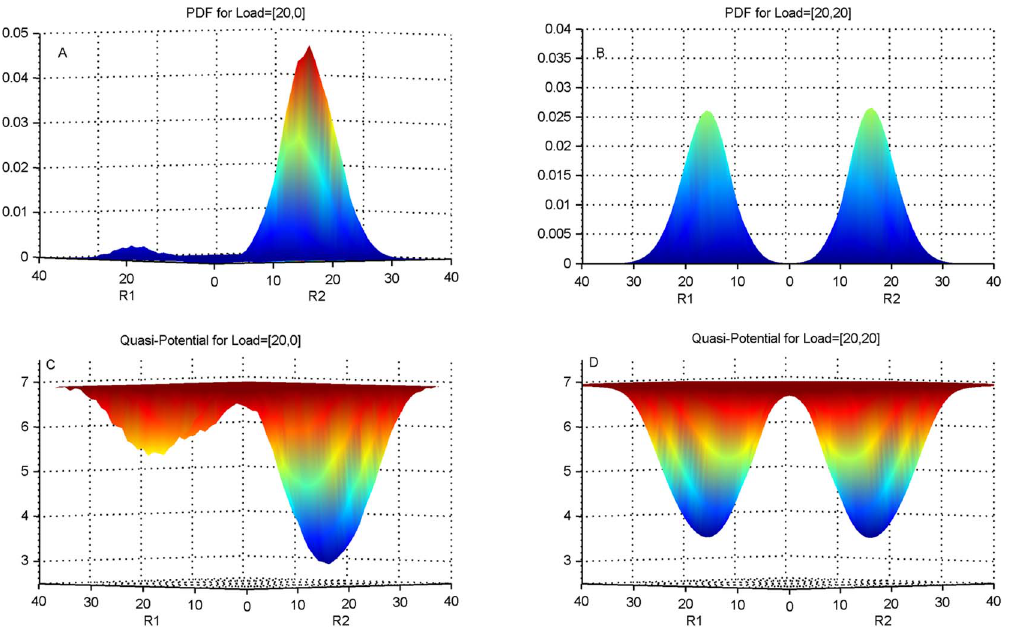
Figure 6. The probability distribution function and quasi-potential of a toggle switch with a load. The 3-dimensional plot is viewed with the xy-plane horizontal for better contrast. The x- and y-axes are numbers of molecules of R1 and R2 while the z-axis is either probabilities or the quasi-potential. (A). The probability distribution function (pdf) of the toggle switch of Fig. 5 but now with a load of 20 molecules on Repressor 1 (R1). (B). The pdf of the toggle switch with a load of 20 molecules on R1 and 20 molecules on R2. (C). The quasi-potential of the toggle with a load of 20 molecules on R1, i.e. corresponding to panel A. (D). The quasi-potential of the toggle with equal loads of 20 molecules on each repressor, i.e. corresponding to panel